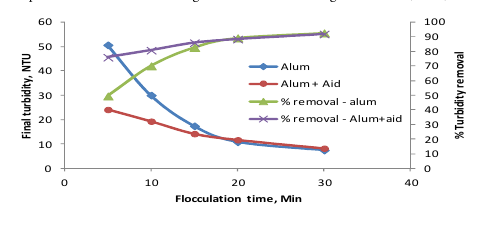
Fig.6. Optimization of alum and coagulant doses for total organic carbon (TOC) removal